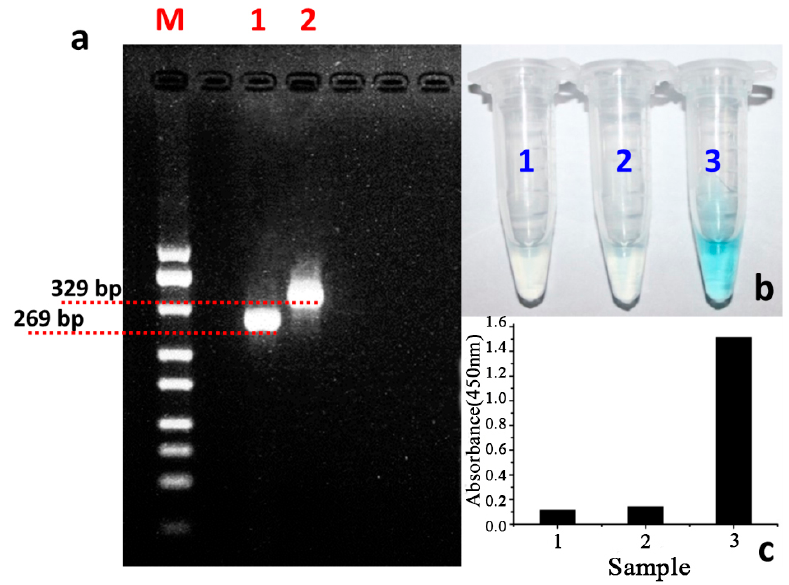
Figure 1. The possibility confirmation results of the developed colorimetric integrated PCR protocol for rapid and easy detection of V. parahaemolyticus . ( a ) The agarose gel electrophoresis results of the PCR products with traditional and designed primer sets, M: marker; lane 1: PCR products